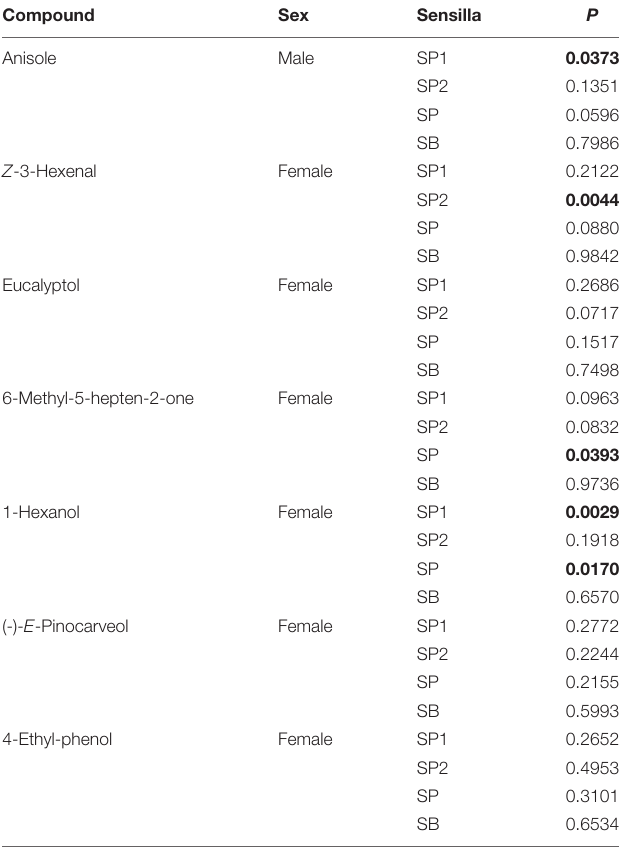
TABLE 2 | Correlations between sensillar abundance and EAG